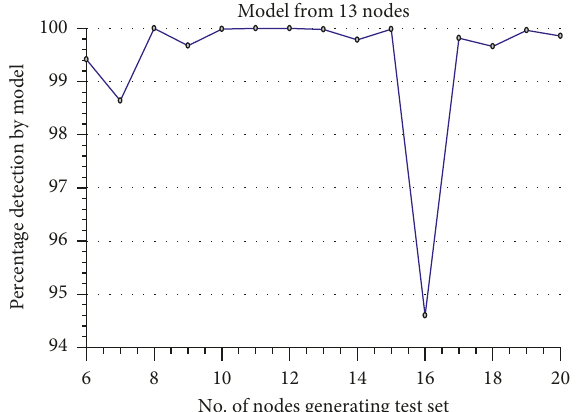
Figure 18: Simulation results for 16 nodes.